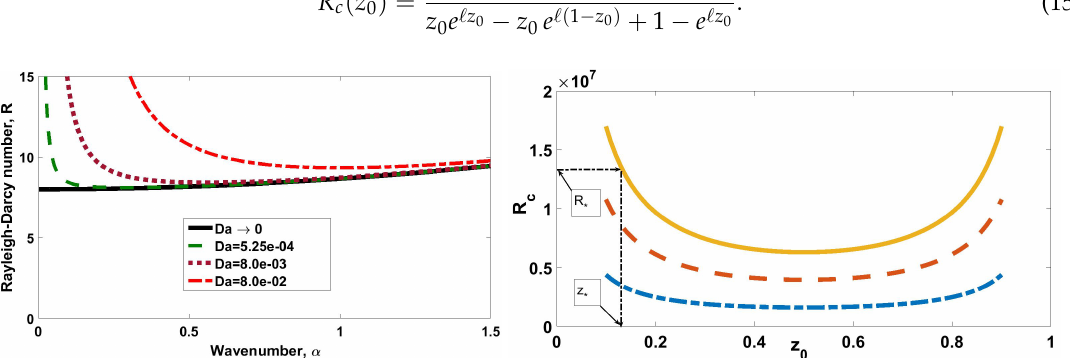
Figure 3. Suppose that for some sequestration site, the physical parameters and the concentration level are such that the Rayleigh–Darcy number is R ∗ . Then, the thickness of the boundary layer at which the instability sets in is given by ( 1 − z 0 ) . If R ∗ happens to be less than the absolute minimum for that particular site, then convection will be absent and the carbon dioxide will dissolve by diffusion alone. Note also that the magnitude of the critical Rayleigh number can be large, so the large R values encountered in sequestration sites is not necessarily an indication of a turbulent mixing [7]. Reproduced with permission from [7].